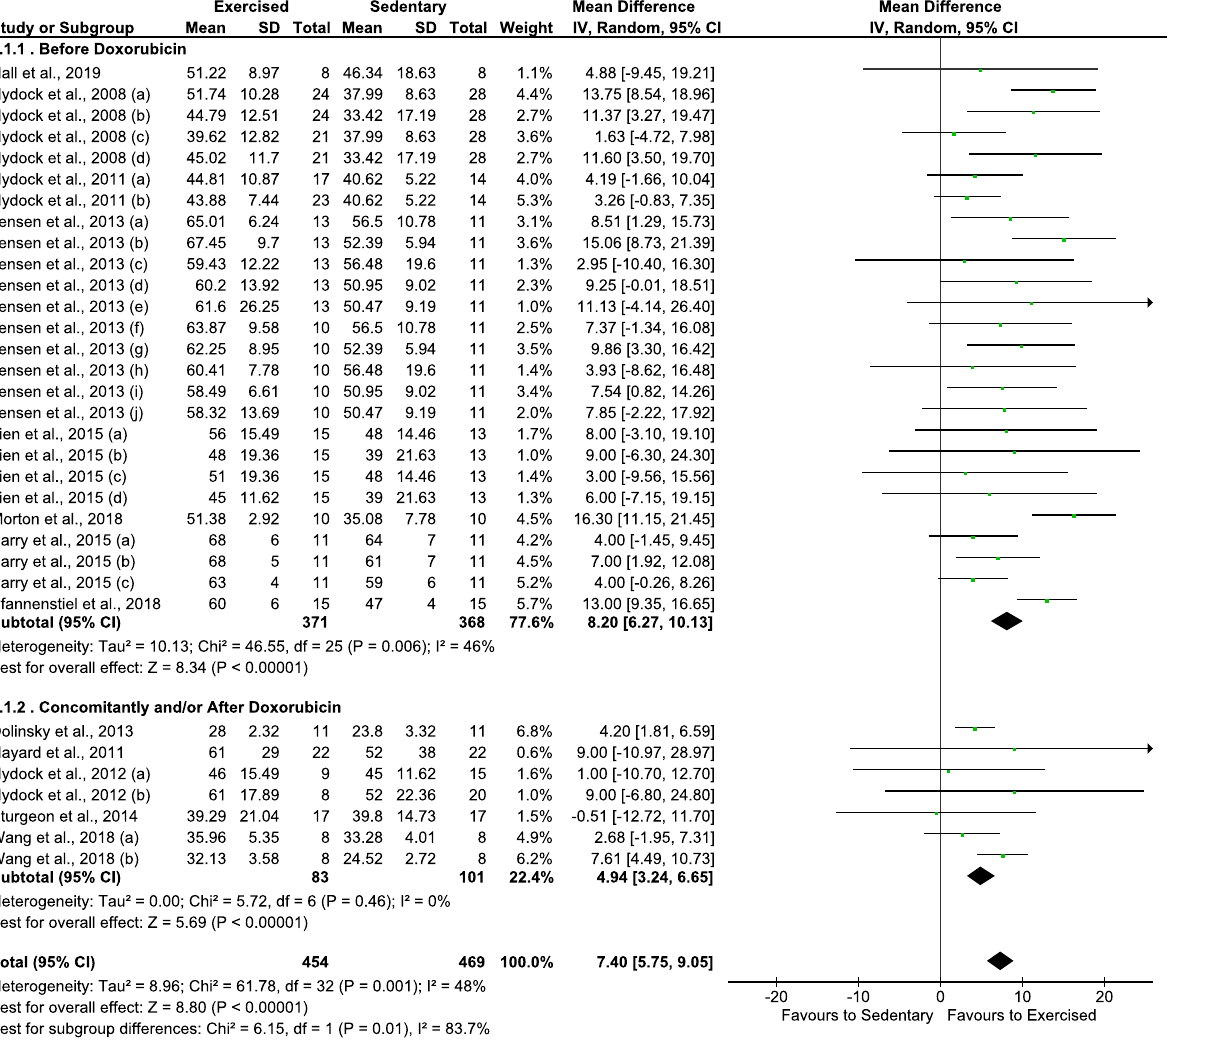
Figure 4. Effects of the timing of exercise protocol in relation to doxorubicin exposure (before vs. concomitantly and/or after) on fractional shortening of animals with doxorubicin-induced Publication bias.